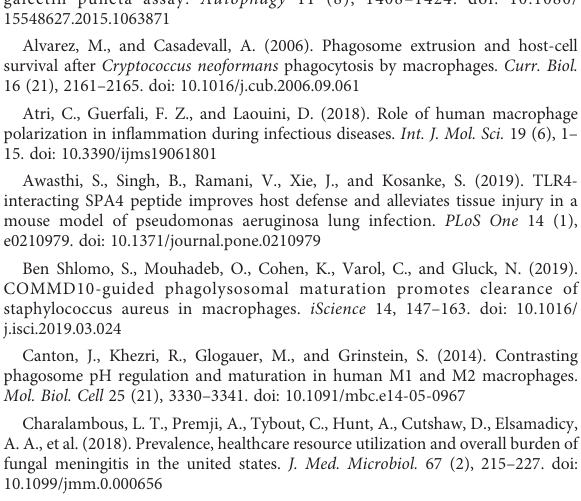
SUPPLEMENTARY VIDEO 8 Video depicting two instances of non-lytic exocytosis (NLE). Notice that immediately after losing fl uorescence (pH neutralization) the yeast cells are expelled from the